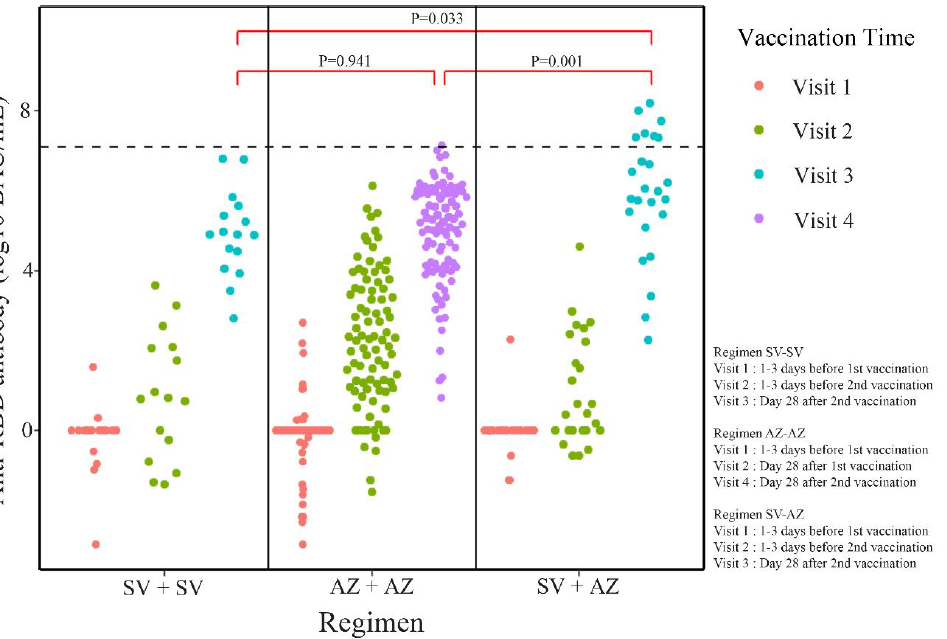
Figure 4. Titer of anti-spike RBD IgG antibodies at different visits of each vaccine regimen. AZ-AZ, homologous AZD1222 regimen; SV-AZ, heterologous Sinovac-AZD1222 regimen; SV-SV, homologous Sinovac regimen.